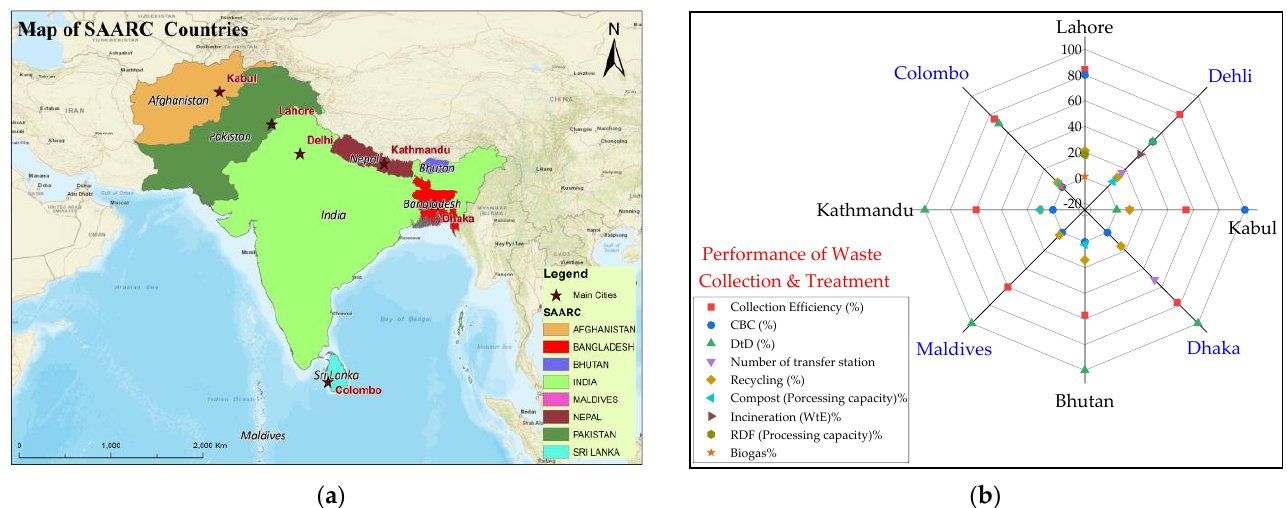
Figure 2. SAARC countries waste sector assessment: ( a ) Map of SAARC countries showing selected cities for waste assessment; ( b ) Assessment of cities against waste management indicators. Further, the low – middle-income cities/countries [43] ranking was performed against the collection efficiency parameter (Figure 3). Tehran, Tashkent, and Beirut are found at the top rank with 100% waste collection efficiency [44 – 47]. Kyiv maintained the second rank with 90% waste collection efficiency [48]. La Paz and Hanoi ranked third with 87% waste collection efficiency [49 – 51]. Ulaanbaatar maintained the fourth rank with 85% collection efficiency [52]. Lahore and Rabat claimed the fifth rank with 84% waste collection efficiency [53].